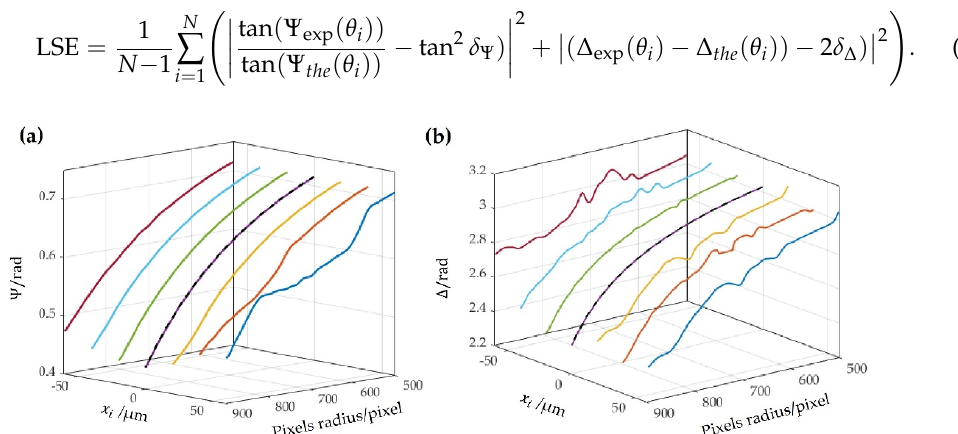
Figure 3. Comparison of the standard 44.34 nm SiO 2 film measured ellipsometric parameters at different defocus positions: ( a ) Ψ and ( b ) Δ ; the black dashed lines represent the ellipsometric parameter of the theory.